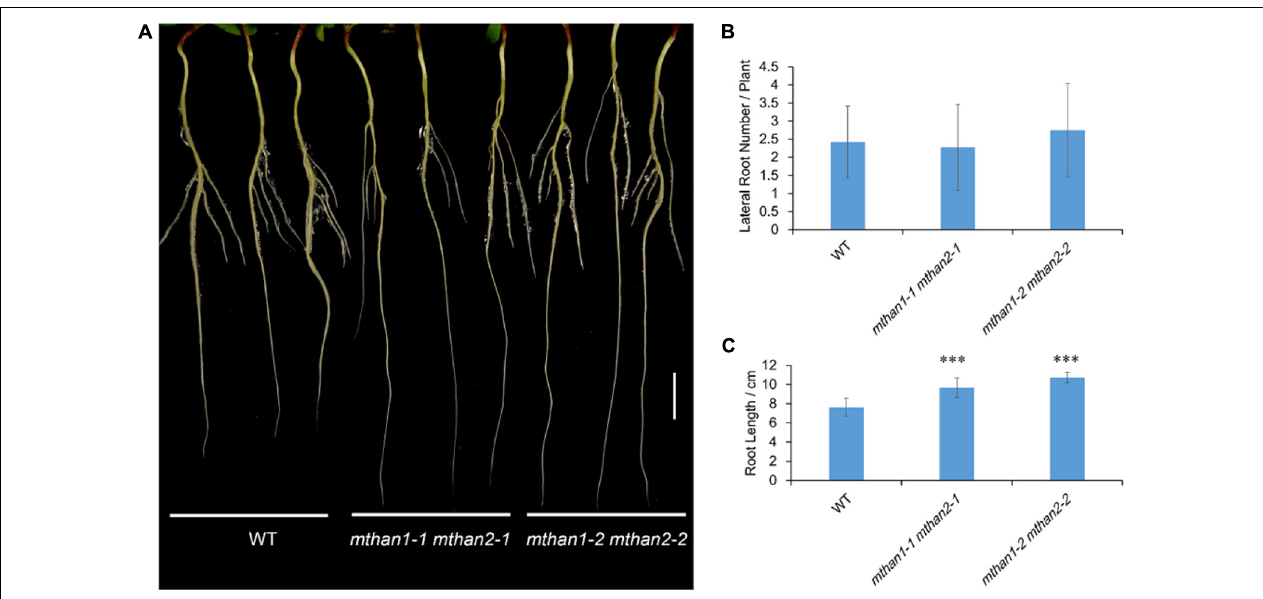
FIGURE 4 | MtHAN1 and MtHAN2 are redundantly involved in the root elongation. (A) Seedling images of WT and mthan1 mthan2 double mutant plants on the seventh day after transferring to MS plates. Three representative seedlings of each plant line were photographed. Bar = 1 cm. (B) Measurement of lateral root number. (C) Measurement of primary root length. Values are the means ± SD ( n = 12). ∗∗∗ P <